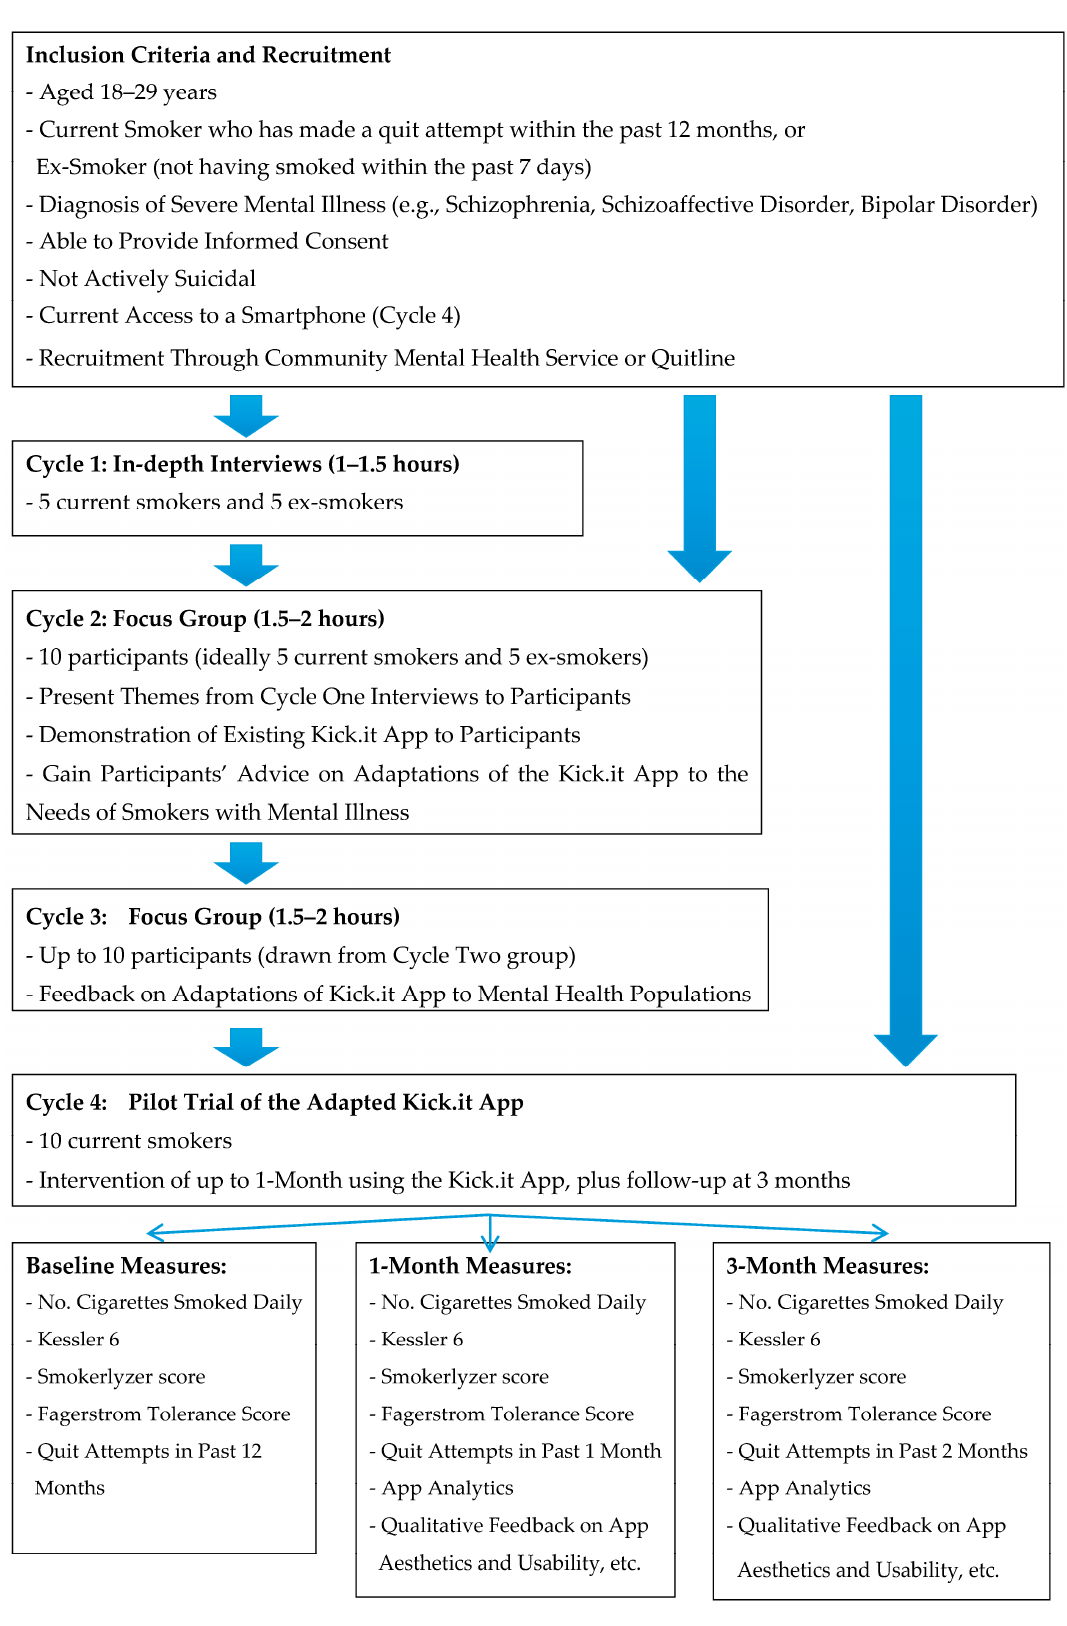
Figure 1. Outline of Kick.it trial protocol components.